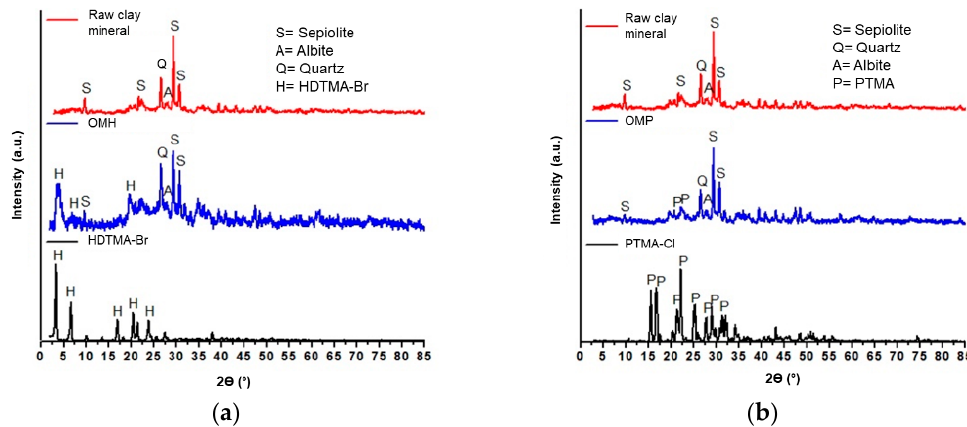
Figure 2. X-ray diffraction (XRD) patterns of the ( a ) raw clay mineral, the organo-modified with hexadecyltrimethylammonium bromide (OMH), and the hexadecyltrimethylammonium bromide (HDTMA-Br) cationic surfactant. ( b ) The raw clay mineral, the organo-modified with phenyltrimethylammonium chloride (OMP) and the phenyltrimethylammonium chloride (PTMA-Cl) cationic surfactant.